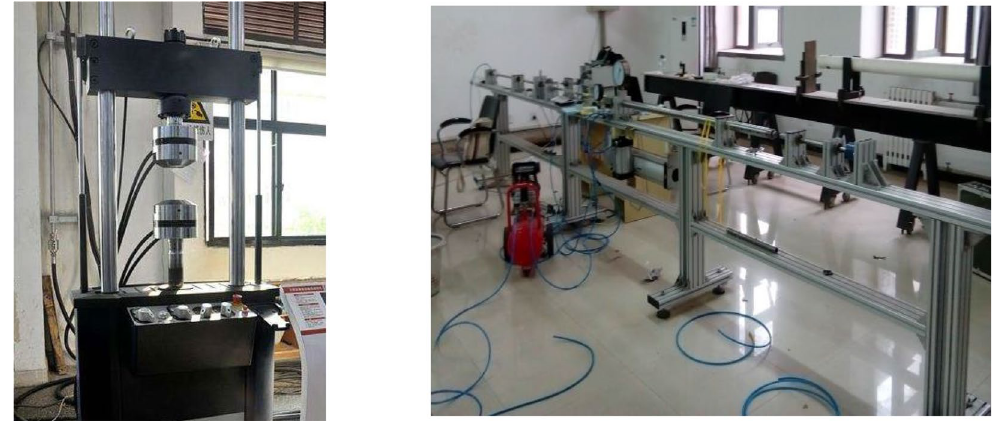
Figure 1. 42CrMo quasi-static